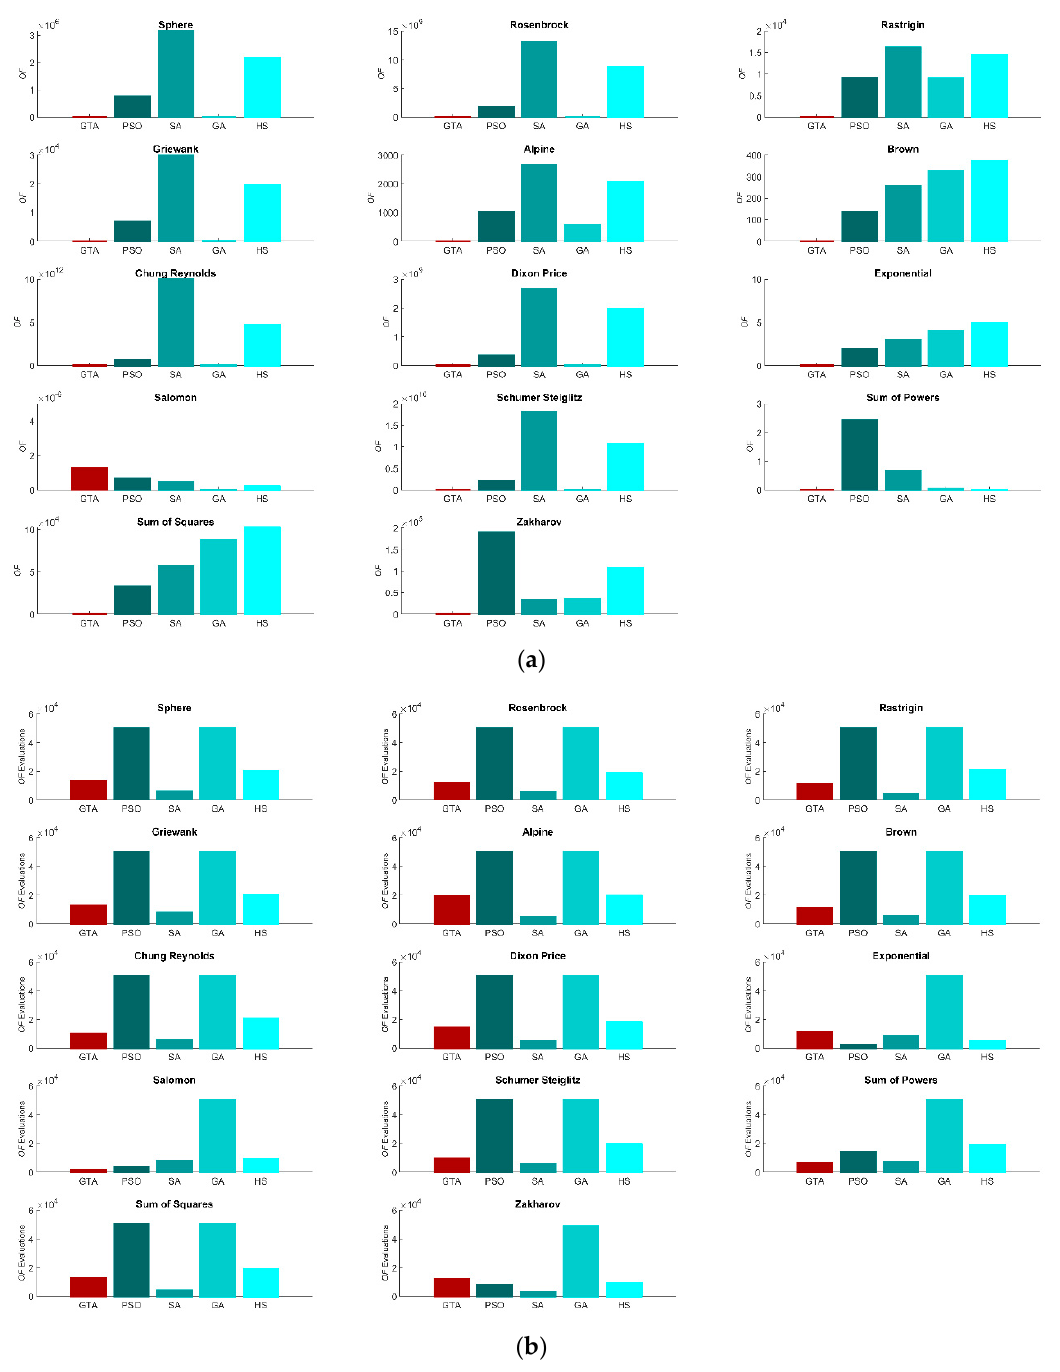
Figure 2. Results of 100 runs with 1,000 variables: ( a ) OF value average; ( b ) OF evaluations average.